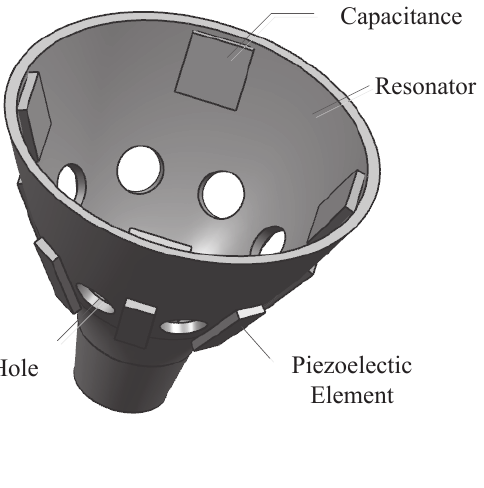
Figure 4. Schematic of a bell-shaped